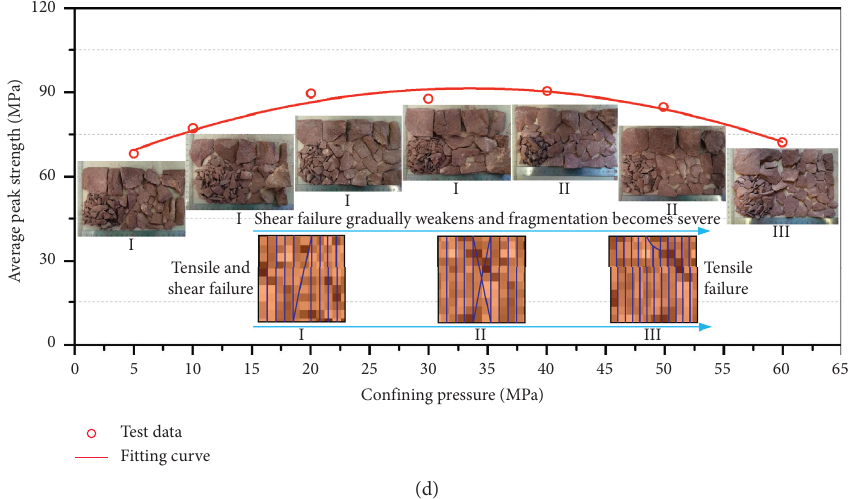
Figure 12: Corresponding relationship between peak strength and failure characteristics: (a) TCT, (b) BCT, (c) TLU, and (d)